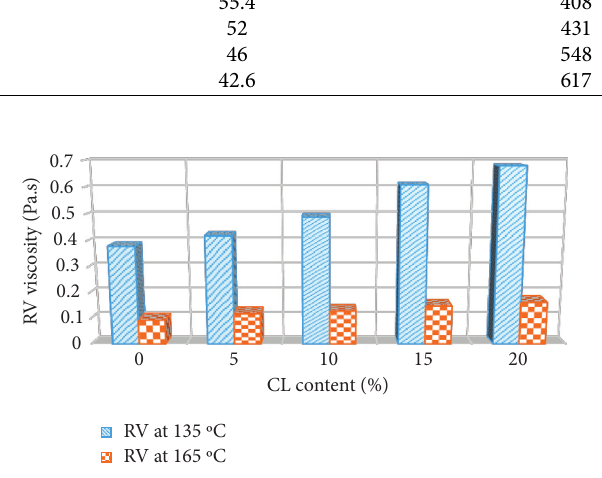
Figure 5: The rotational viscosity test results.